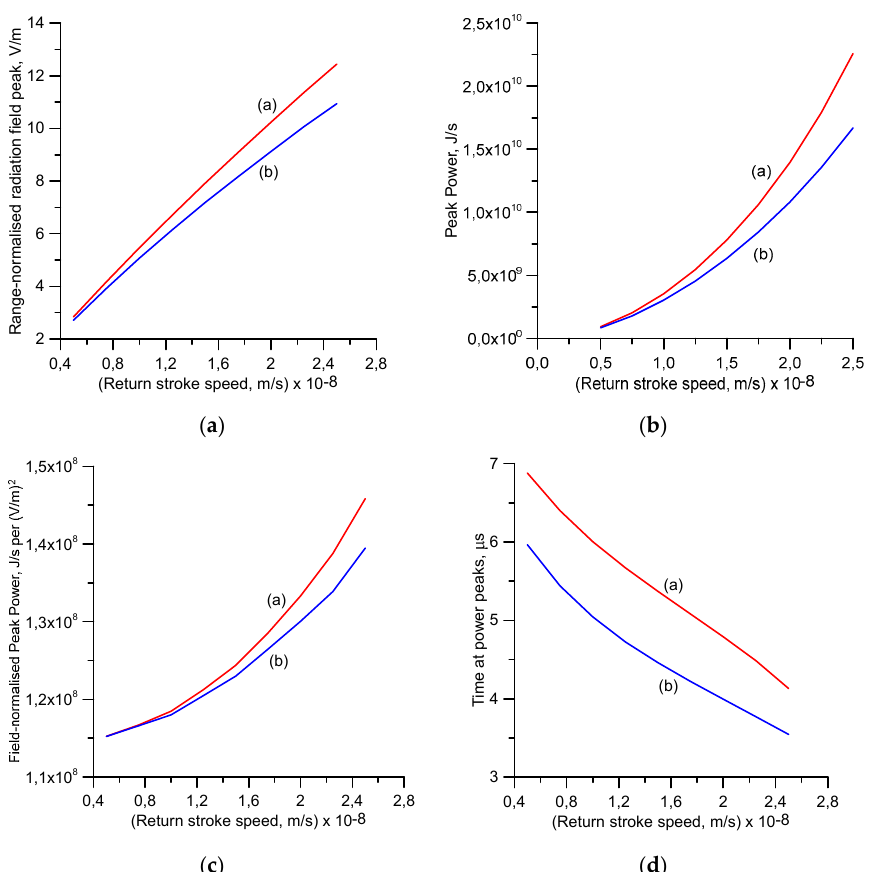
Figure 9. Data pertinent to the peak power radiated by a first return stroke supporting a channel base peak current of 30 kA. ( a ) The range-normalized (to 100 km) peak radiation field at ground level as a function of the return stroke speed; ( b ) The peak power generated by the return stroke as a function of the return stroke speed; ( c ) The field-normalized peak power obtained by dividing the peak power by the square of the radiation field peak at 100 km; ( d ) The time at which the power peaks as a function of the return stroke. (a) MTLL model; (b) MTLE model.